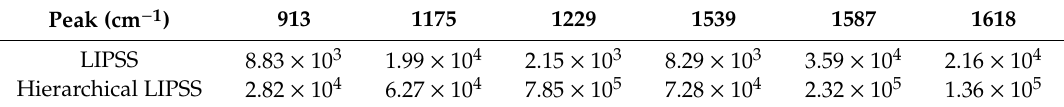
Table 1. Peak position value of the surface-enhanced Raman scattering (SERS) spectra and calculated enhancement factors (EFs) of Crystal Violet (CV) adsorbed on LIPSS and hierarchical LIPSS